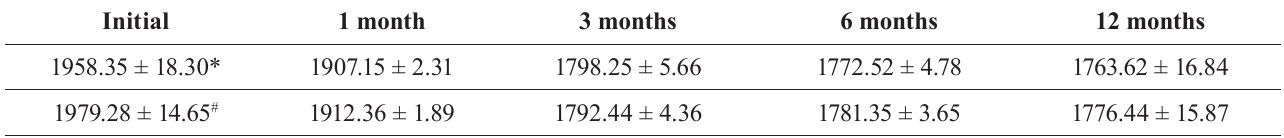
TABLE V - T otal phenols content in the gels during the 12 months of storage expressed in µg/g